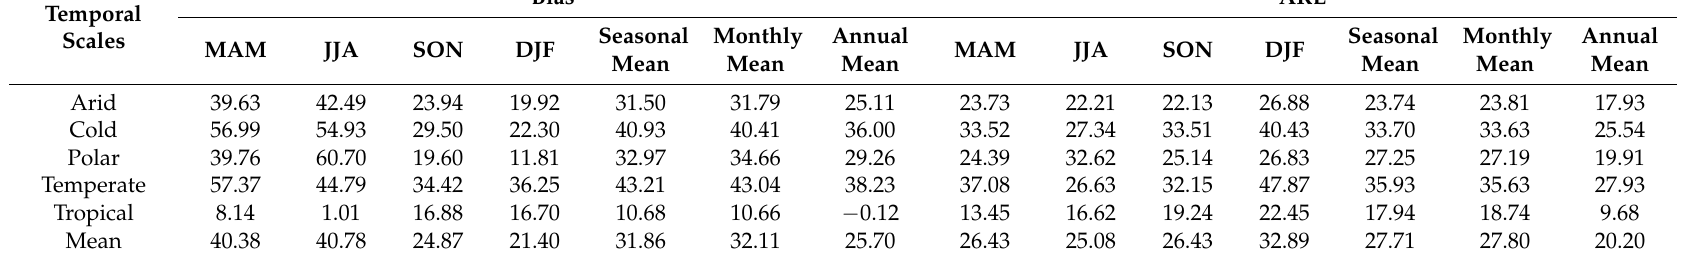
Mean Temporal Scales MAM JJA SON DJF Arid